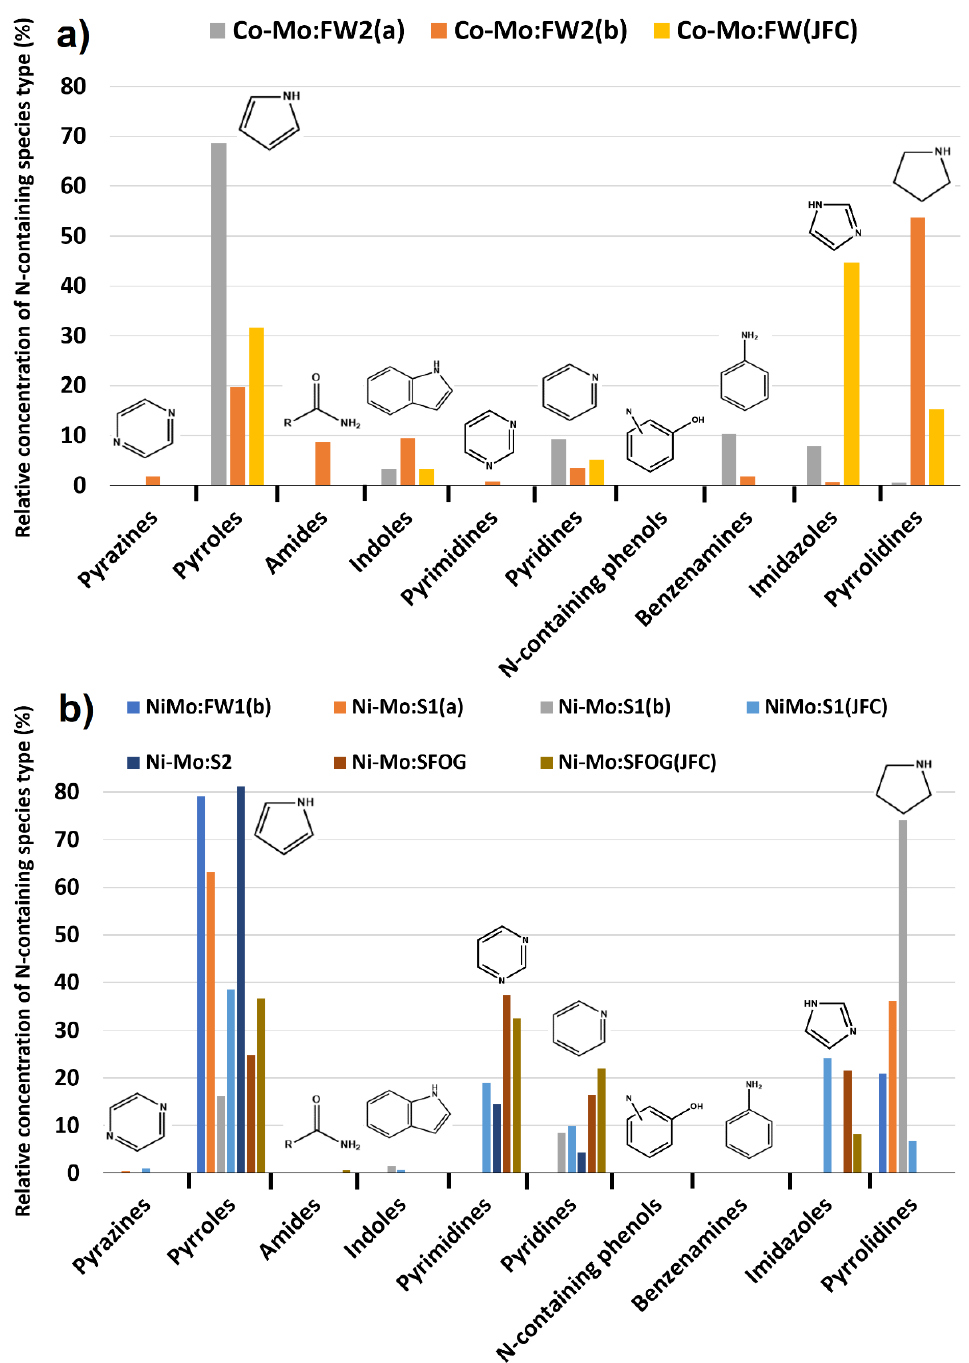
Figure 4. Relative concentrations of classes of nitrogenates present in a selection of upgraded WWHTLBs produced via hydrotreatment with ( a ) CoMo or ( b ) NiMo catalyst, as determined by